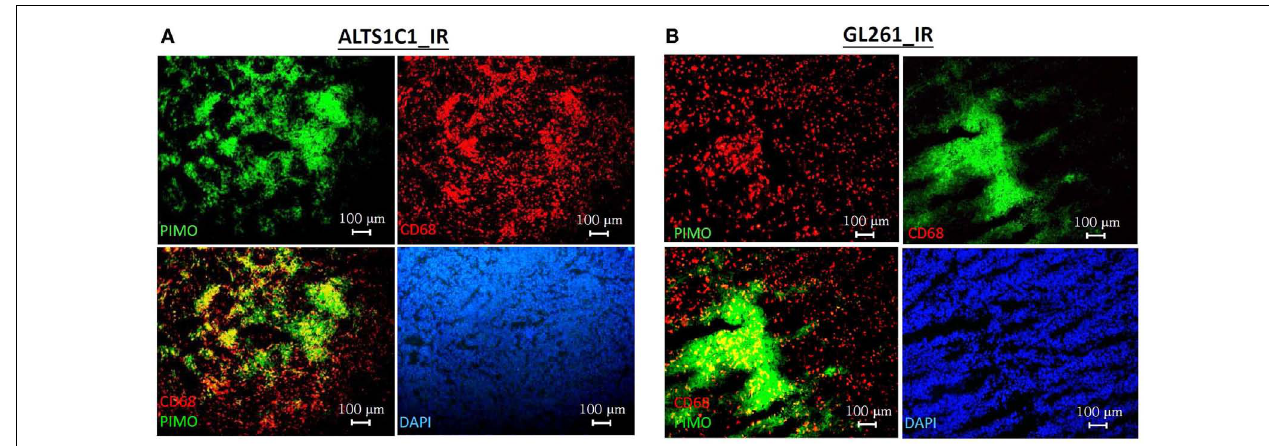
FIGURE 4 | Irradiation induces CD68 + TAMs aggregation in hypoxic regions in bothALTS1C1 and GL261 i.c. tumor models. The distribution of CD68 + TAMs and PIMO + hypoxia in 8Gy-irradiated ALTS1C1 astrocytoma